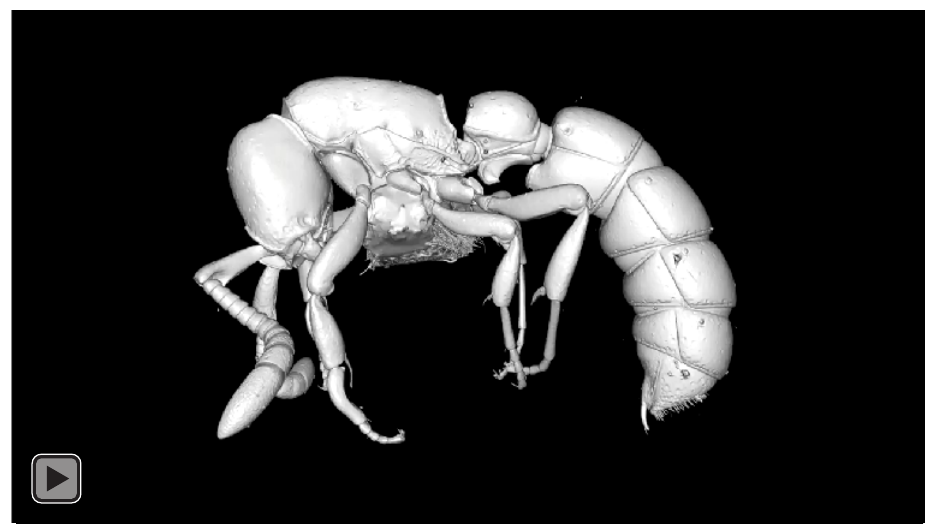
Video 2. 3D rotation video of Zasphinctus sarowiwai sp. n. paratype worker (CASENT0764650) based on shaded volumetric surface rendering of full